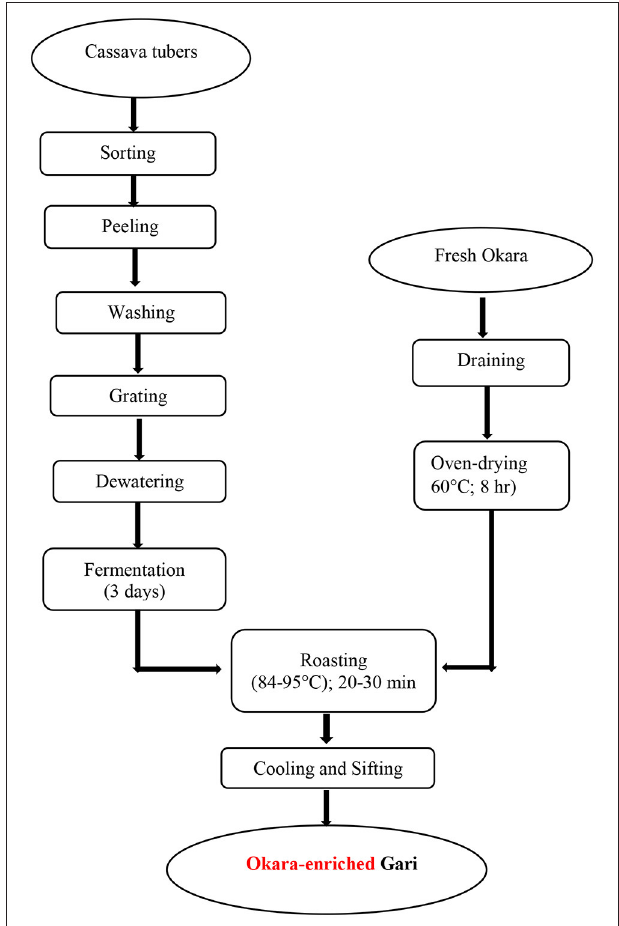
FIGURE 1 | Preparation of Okara-enriched